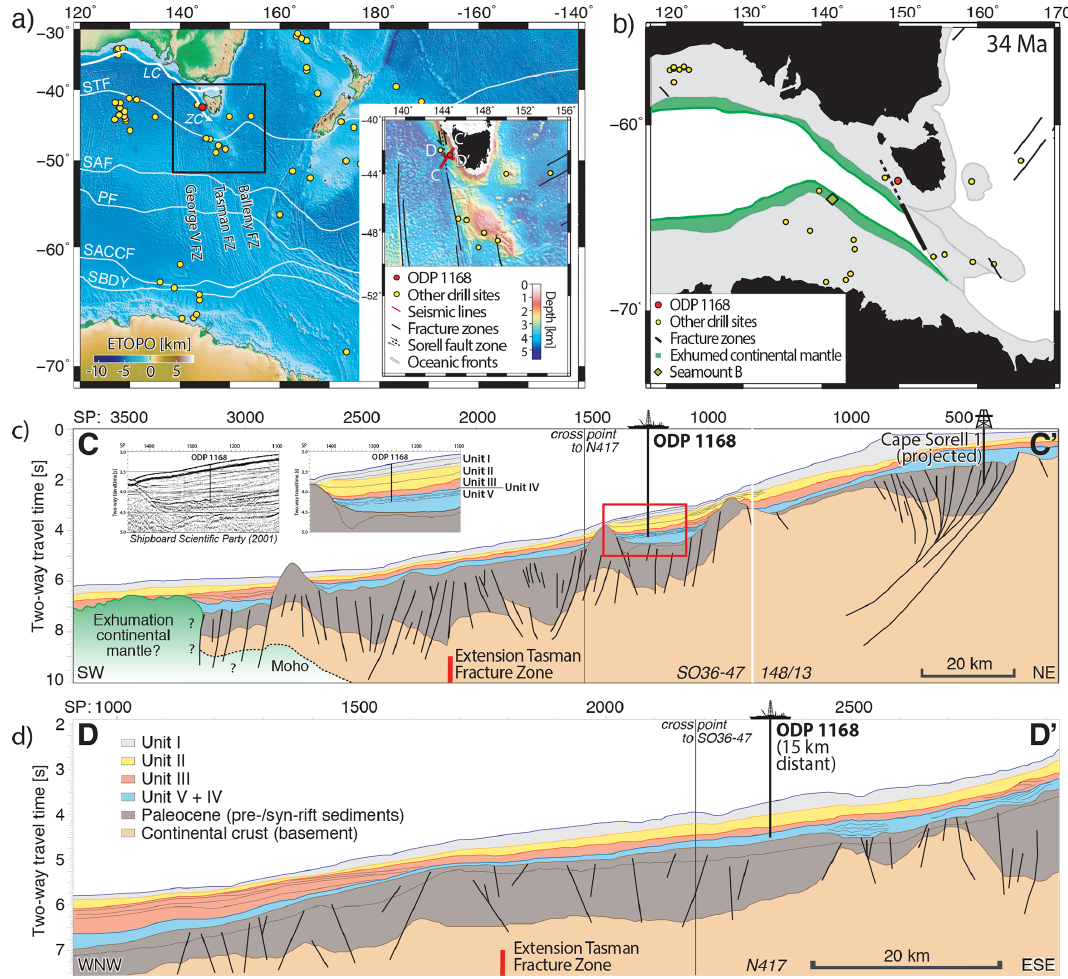
Figure 1. (a) Present-day map of the Australian sector of the Southern Ocean showing ODP Site 1168 (red dot), other drill sites mentioned in this study (yellow dots), ocean fronts (white lines; STF is the subtropical front, SAF is the subantarctic front, PF is the polar front, SACCF is the Southern Antarctic Circumpolar Current front and SBDY is the southern boundary) and southern Australian ocean currents (white arrow; LC is the Leeuwin Current and ZC is the Zeehan Current). The map uses the regional 1min gravity-derived Earth Topography and Bathymetry map (Weatherall et al., 2015). The inset shows high-resolution shipboard bathymetry data from the study area (gaps filled with the Earth Topography and Bathymetry map) with seismic profiles presented in this study (red lines), prominent fracture zones (black lines) and the extended Sorell Fault Zone (dashed line; after Miller et al., 2002). (b) Palaeogeographic map of the Tasman region at 34Ma (using the plate model of Whittaker et al., 2013) with the location of the interpreted exhumed continental mantle domain along the Australian–Antarctic ocean–continent transition (green region; after McCarthy et al., 2020). Panels (c) and (d) interpreted multichannel seismic reflection profiles crossing ODP Site 1168 (for the location, see panel b ; for details, see the legend). (c) The inset panels show the uninterpreted (Exon et al., 2001b) and interpreted seismic section crossing ODP Site 1168 with tied lithological units. Also shown are the pre-Eocene–Oligocene transition sediment stratigraphy after Sauermilch et al. (2019a) and Hill et al. (1997), and the interpreted continental mantle exhumation following McCarthy et al. (2020). Panel (d) shows the legend of the sedimentary units (Exon et al.,